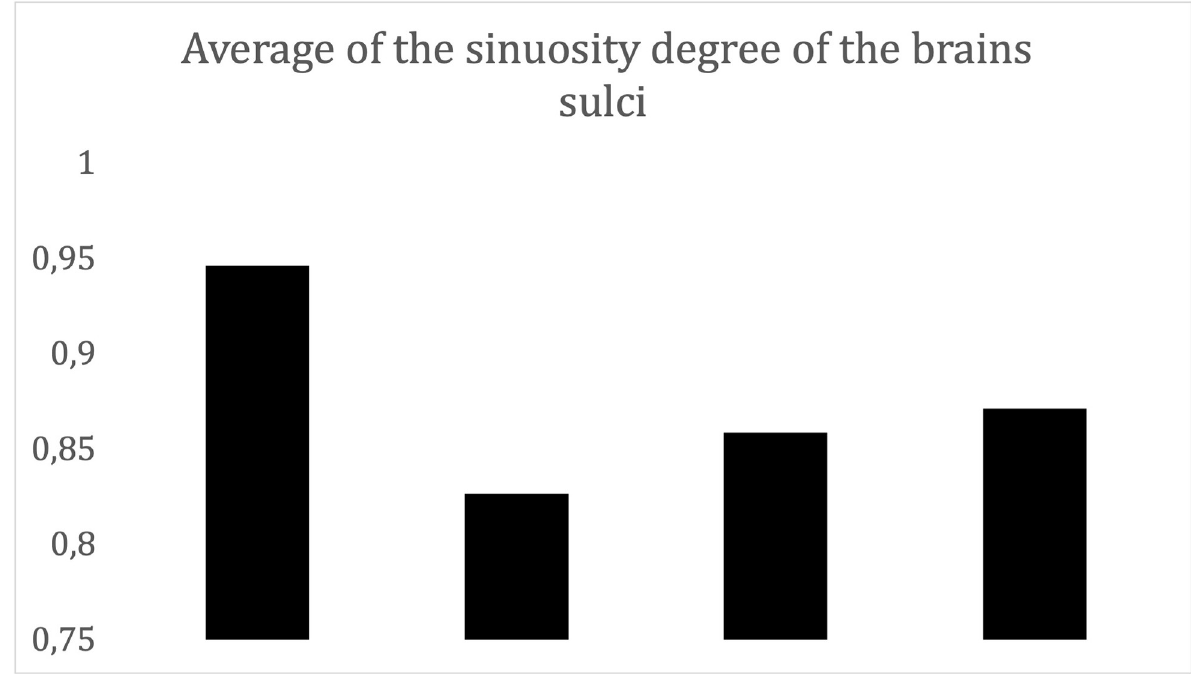
Fig 6. Mean degree of sinuosity of Callithrix penicillata , Saimiri ustus , Sapajus libidinosus , and Brachyteles arachnoides . The larger the value is, the smaller is the sinuosity.